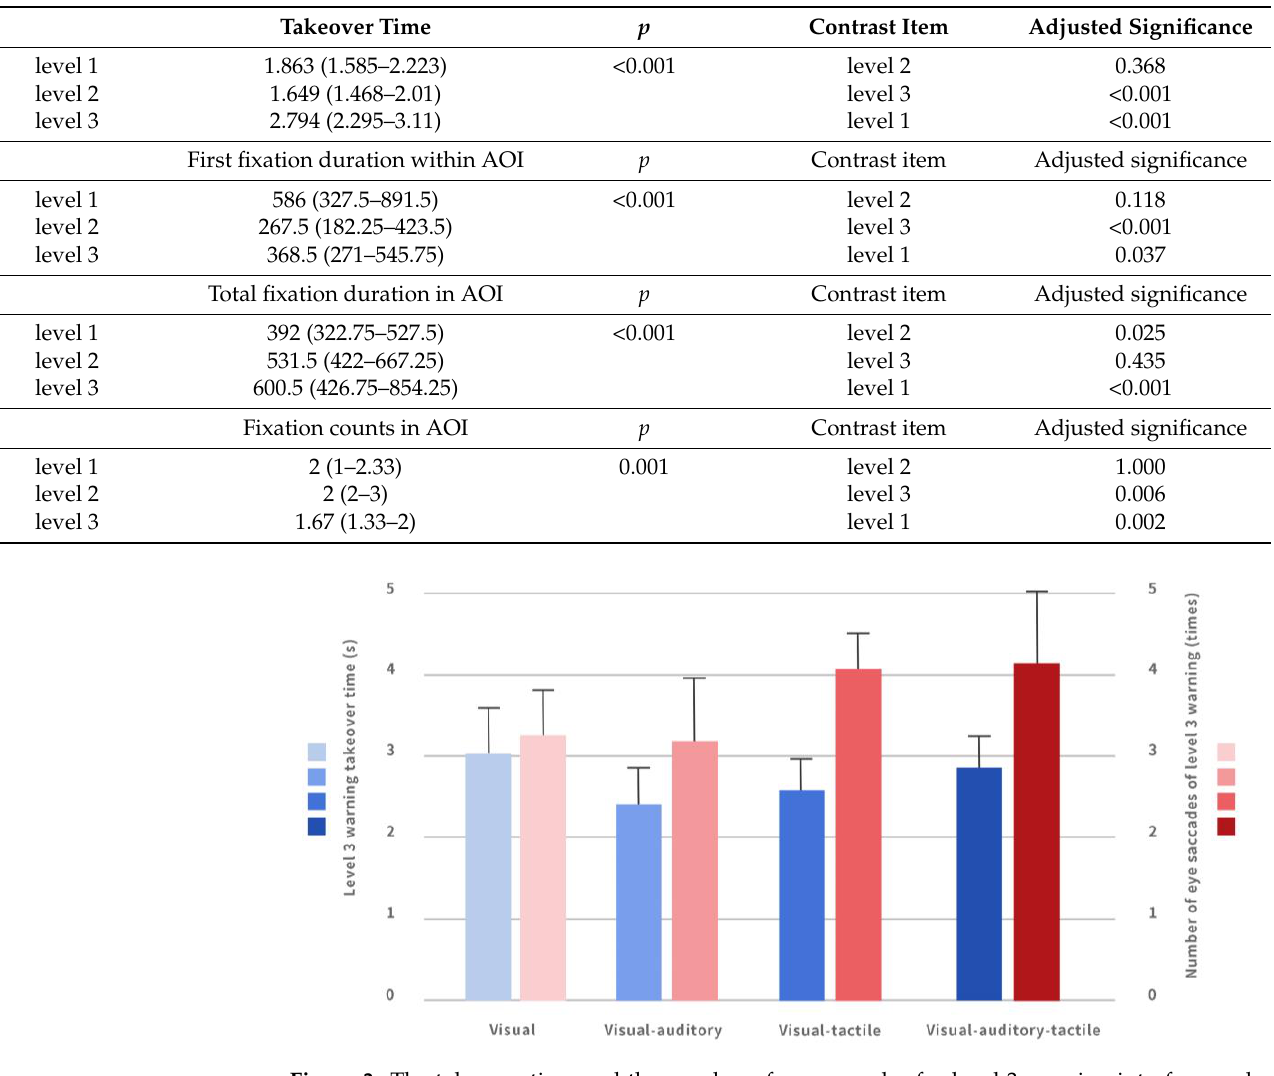
Figure 3. The takeover time and the number of eye saccades for level 3 warning interface under different warnings.